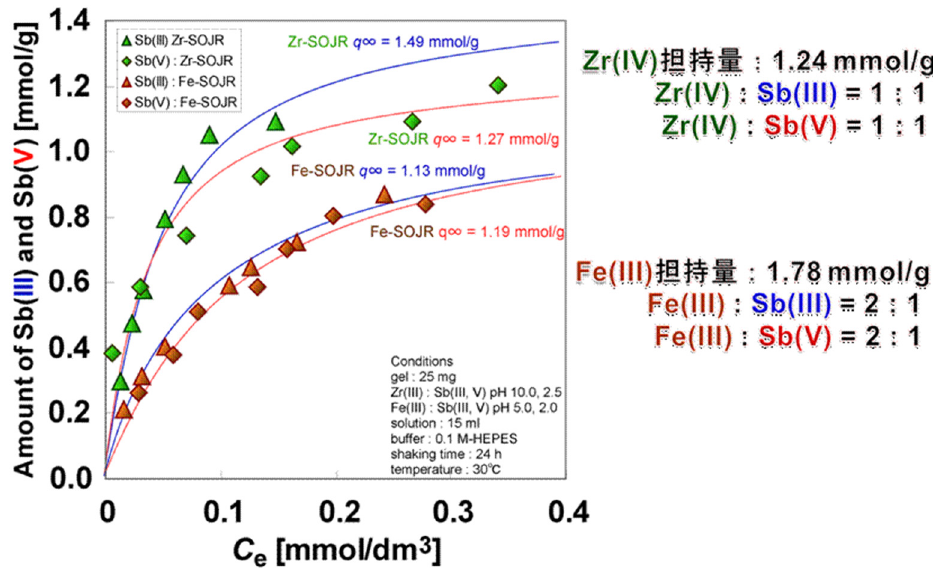
Figure 28. Sb(III) and Sb(V) adsorption isotherms for Zr(IV) and Fe(III)-loaded SOJR gels at 30 °C .